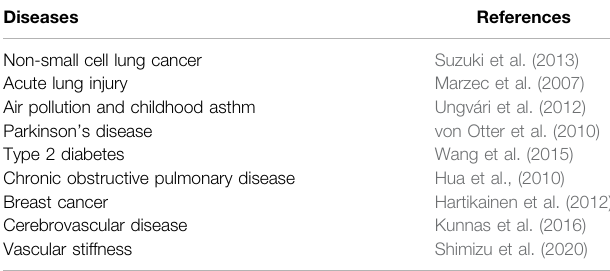
TABLE 4 | Representative diseases associated with NRF2 polymorphism.